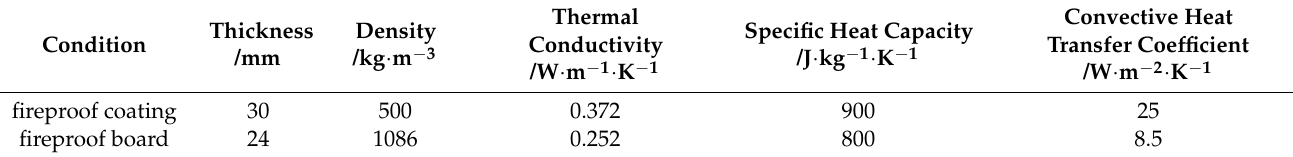
Table 3. Values of Thermal Parameters of Fireproof